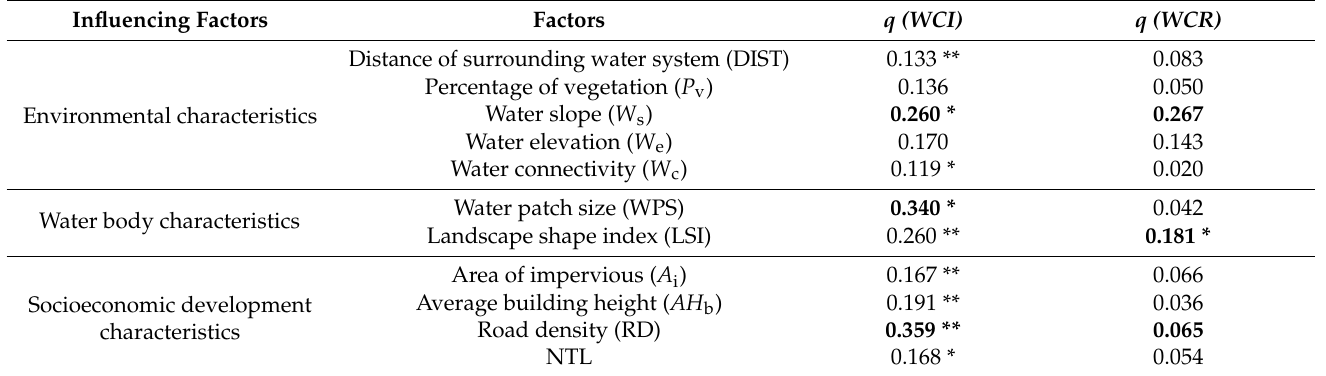
Table 4. The results of factor detector analysis between influencing factors and UBI cooling effect.